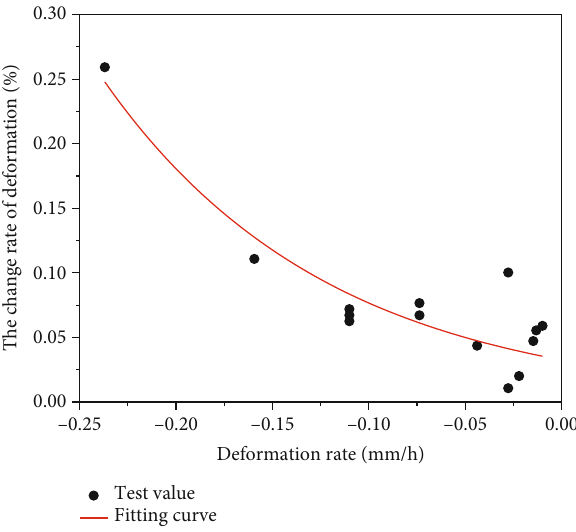
Figure 21: Relation between the change rate of deformation and deformation rate of HS. Table 5: Parameter values of three experimental soil fi